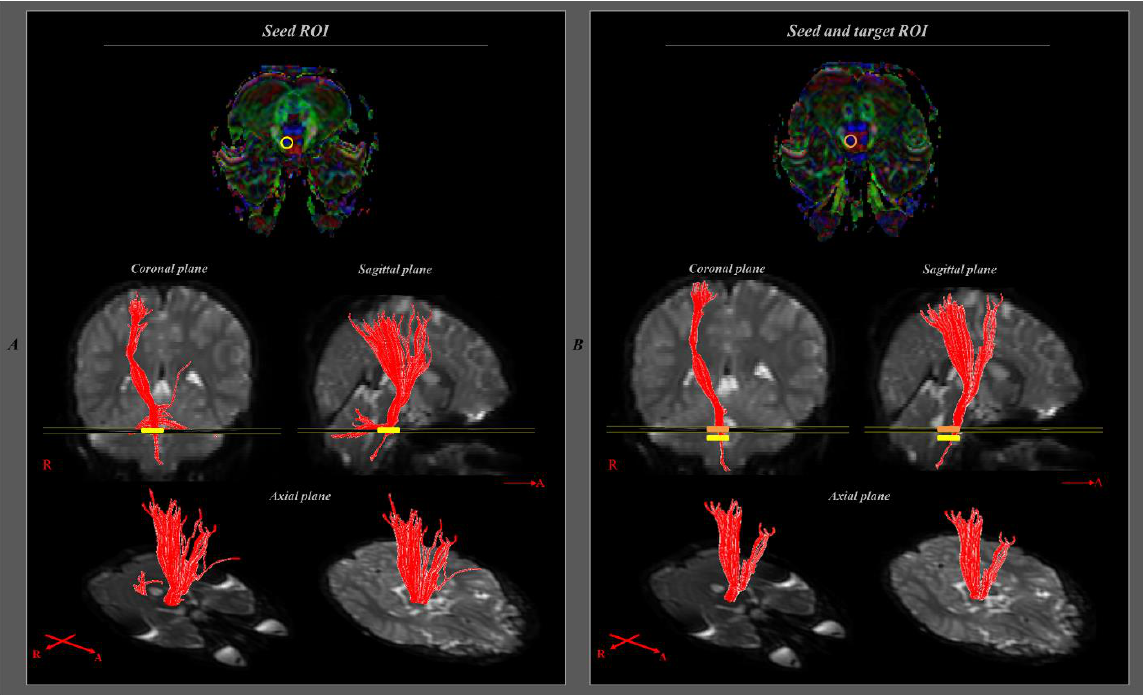
Figure 1. Diffusion tensor tractography tracking process. For the corticospinal tract analysis, the seed region of interest (ROI; yellow circle) was placed on the corticospinal tract portion of the pontomedullary junction, and the target ROI (orange circle) was positioned on the corticospinal tract portion of the anterior mid pons. When performing fiber tracking with one ROI (seed ROI), the transpontine fibers and pontocerebellar tract were also analyzed ( A ). However, the result of tracking with two ROIs (seed + target ROIs) revealed removed transpontine and pontocerebellar tracts, and only the corticospinal tract was analyzed ( B